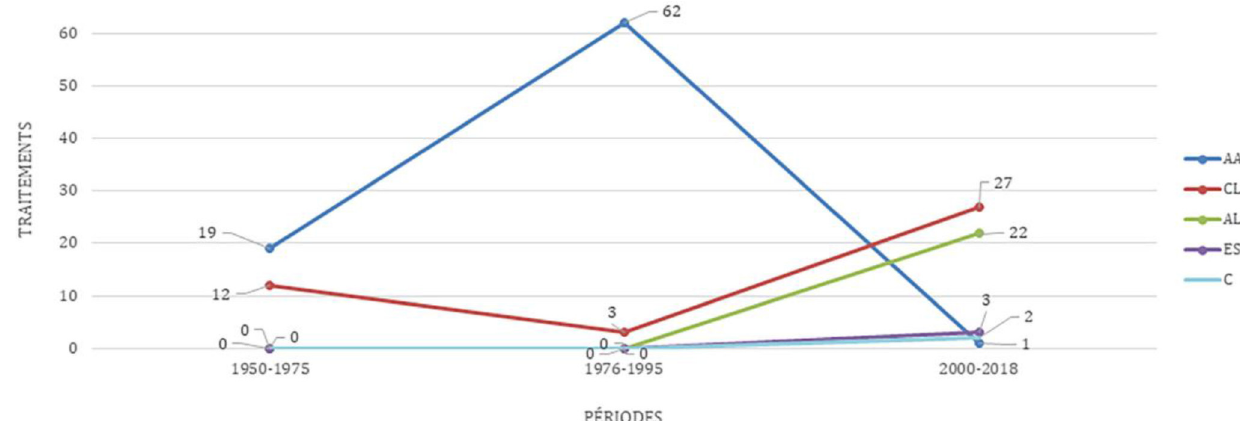
Fig 7. Surgical approaches as a function of time. AA: alveolar approach; CL: Caldwell-Luc; LA: lateral approach; SE: sinus endoscopy by meatotomy; C: combination of transoral and transnasal approaches.